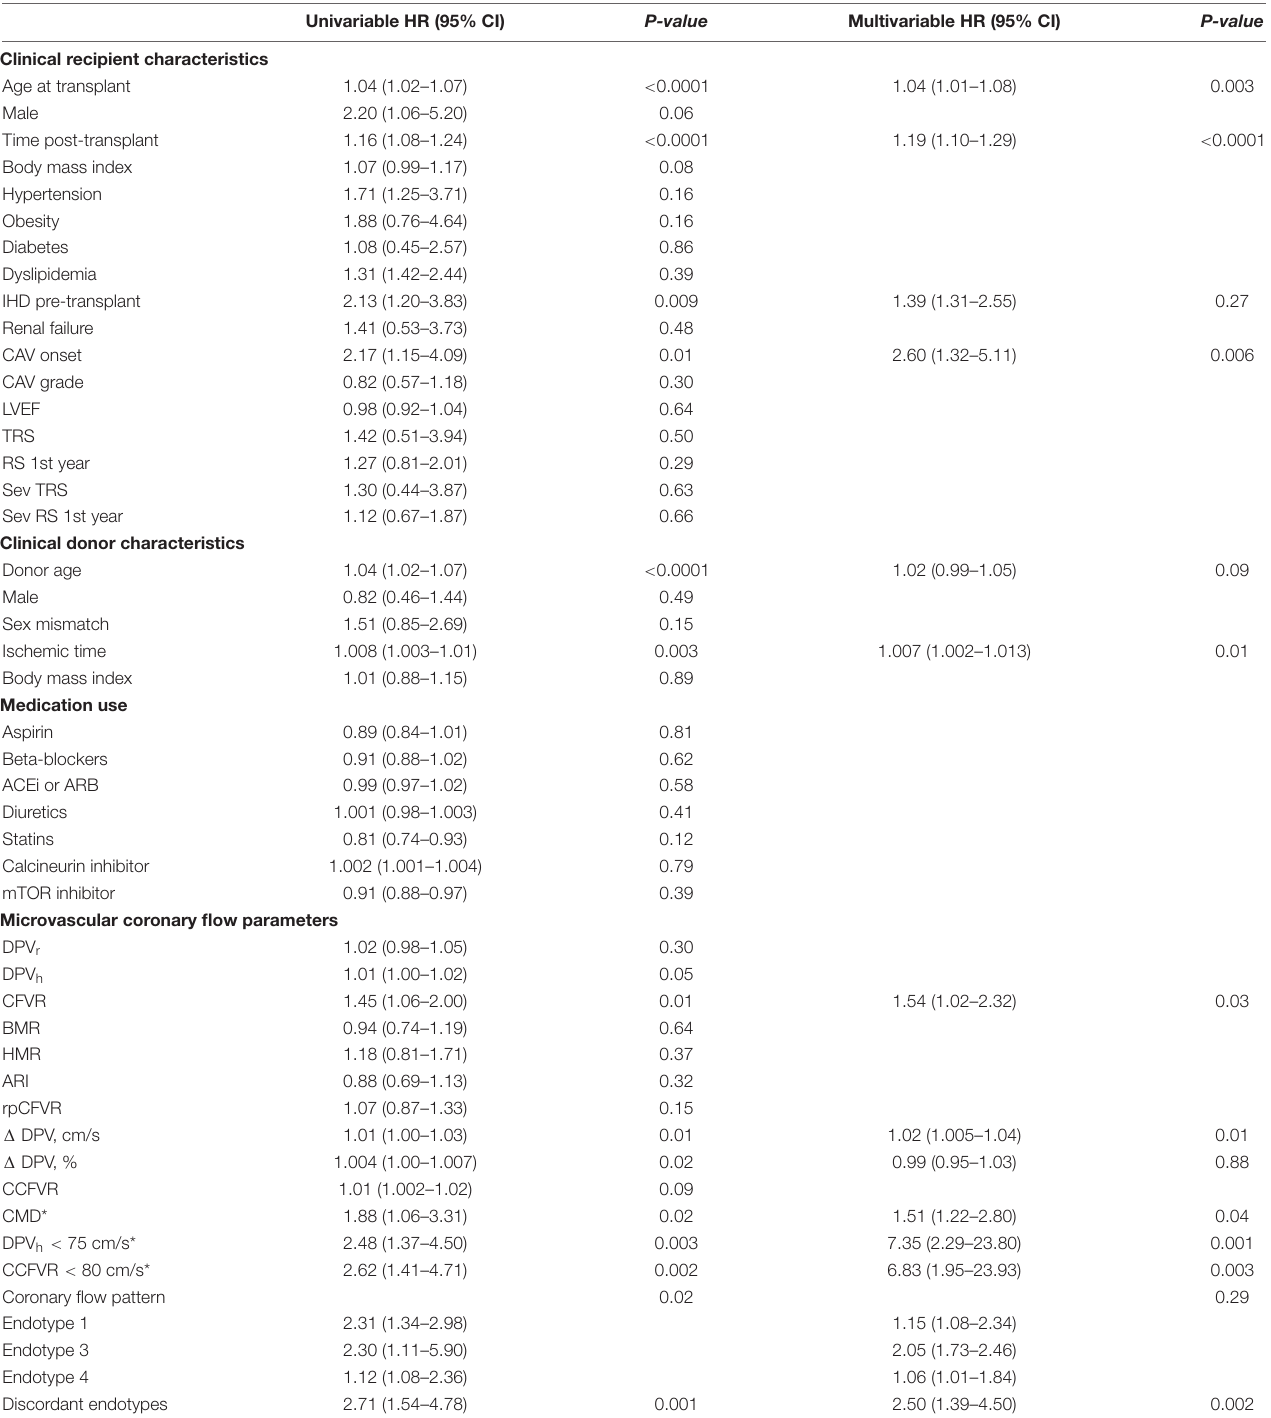
TABLE 5 | Univariate and multivariable Cox proportional hazard regression analysis to identify independent predictors of cardiovascular